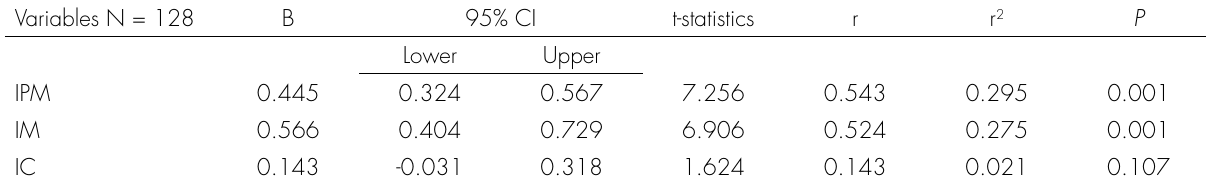
Table VII. Correlation for measured arch width in relation to predicted arch width.